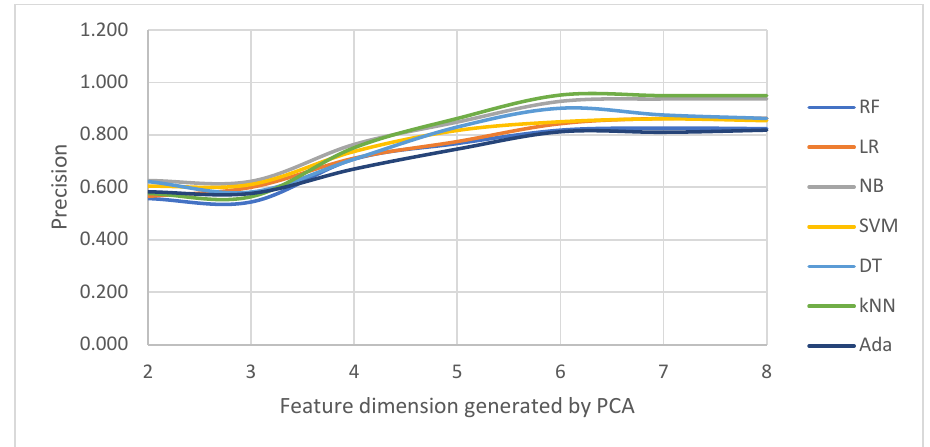
Fig. 13. Precision results for the comparison between different machine learning models using PCA